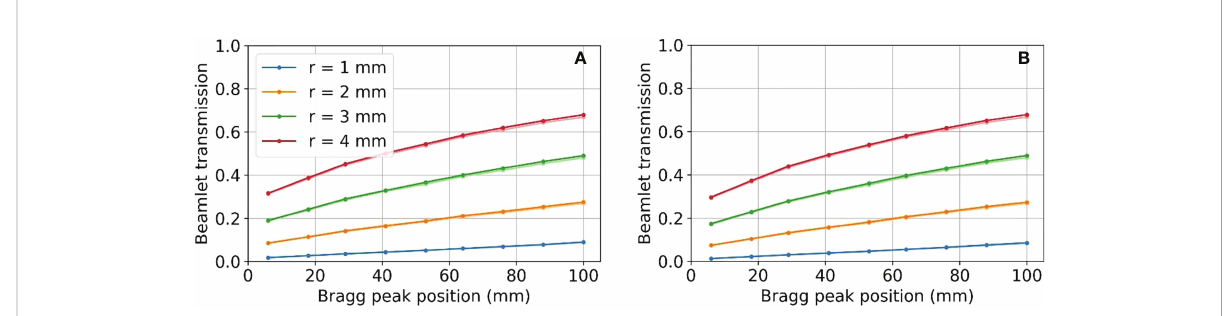
FIGURE 10 Beamlet transmission for SSA opening radii from 1 to 4 mm, placed at an ASD of 50 mm for (A) tungsten on the left and (B) nickel on the right. Lighter colored lines represent the resulting beamlet transmission where there was a 1 mm misalignment of the aperture. Two lines are almost overlapped with each other.